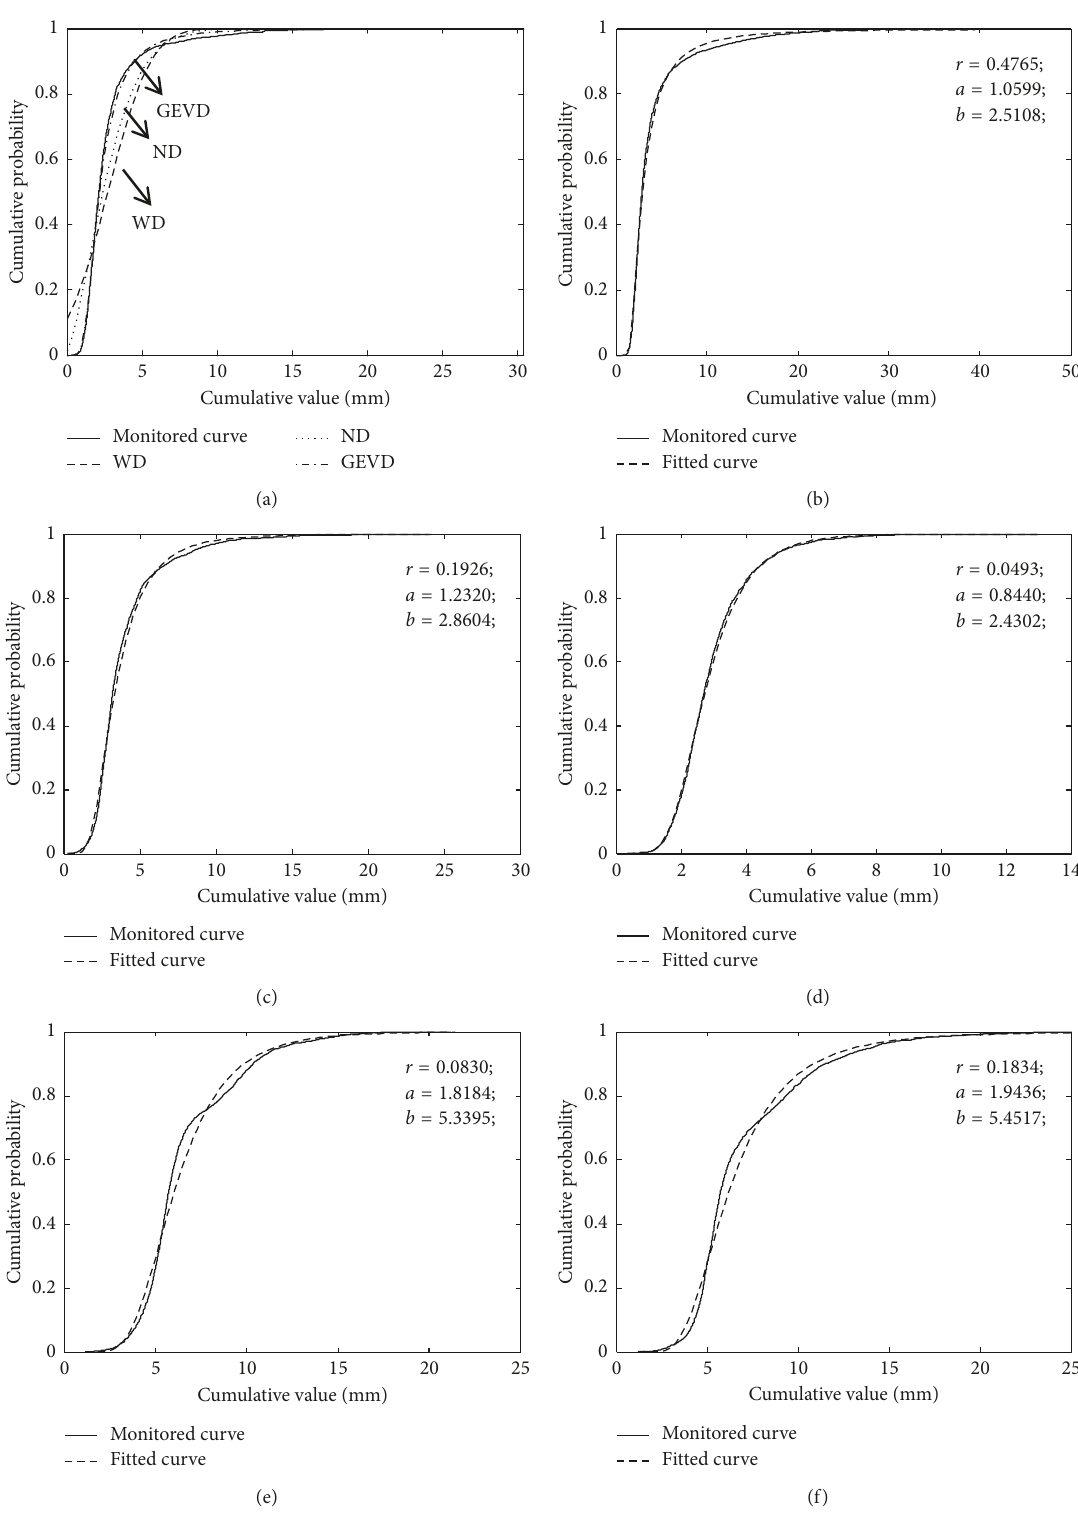
Figure 10: GEVDs of N